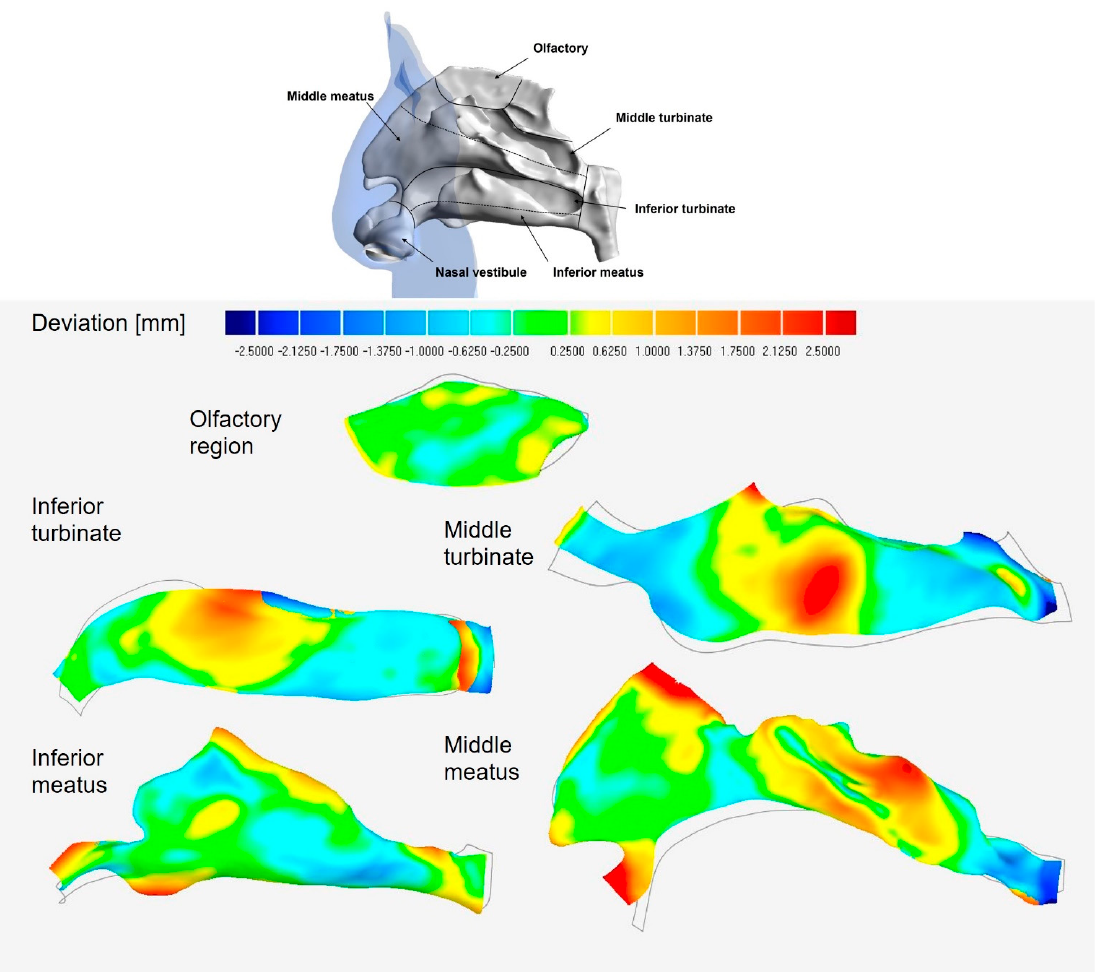
Figure 7. Localised deviation colourmap of the lateral wall, of which red represents deviated to left and blue is the opposite. Corresponding regions in the left chamber were used as the reference location and the right septum was analysed. Table 2. Nasal lateral wall regional deviation information.